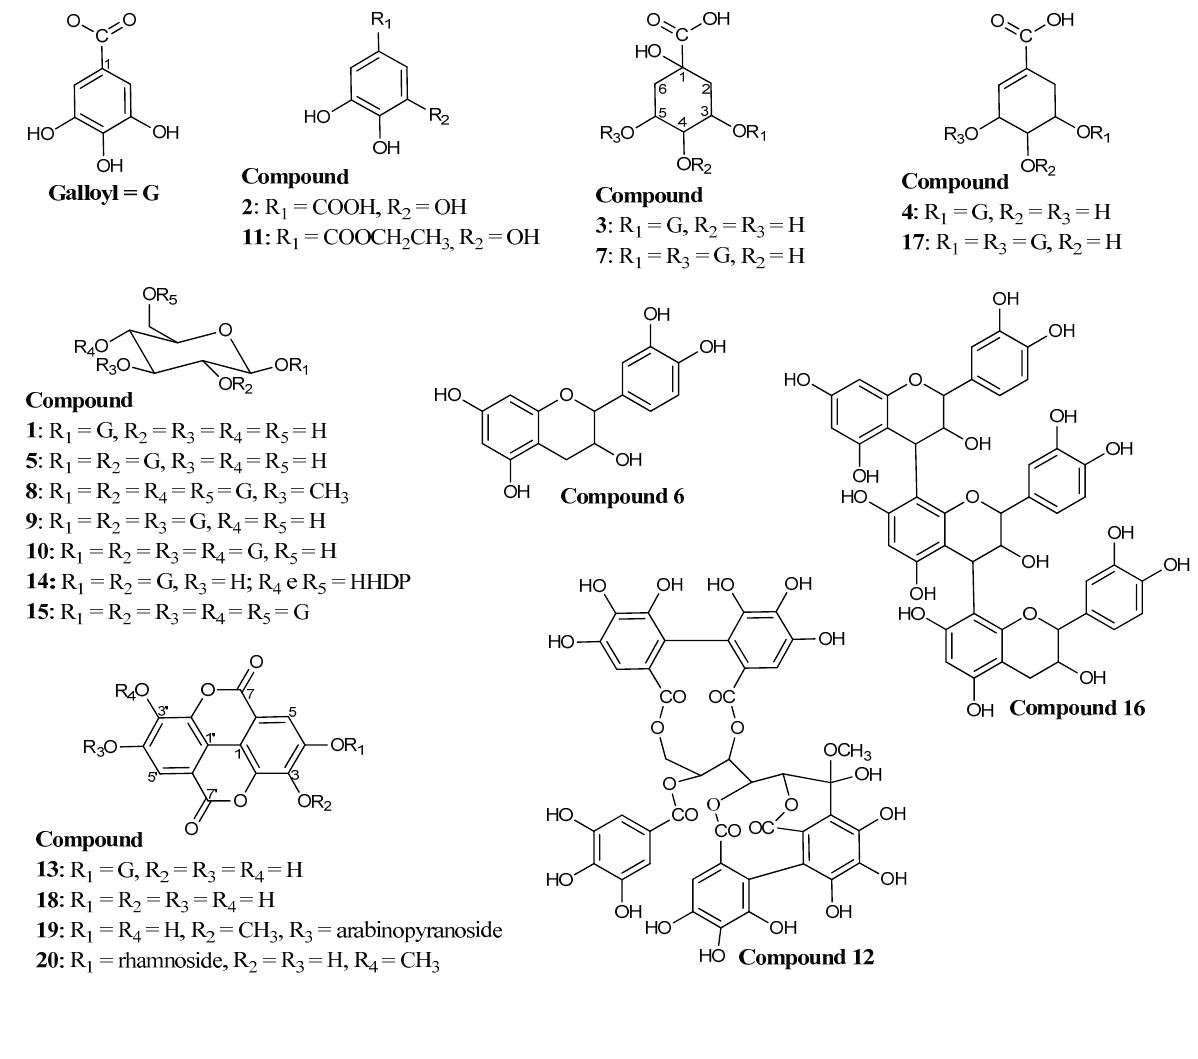
Figure 1. Structures of the twenty constituents identified in the ethanolic extract of the stem bark of C . ferrea